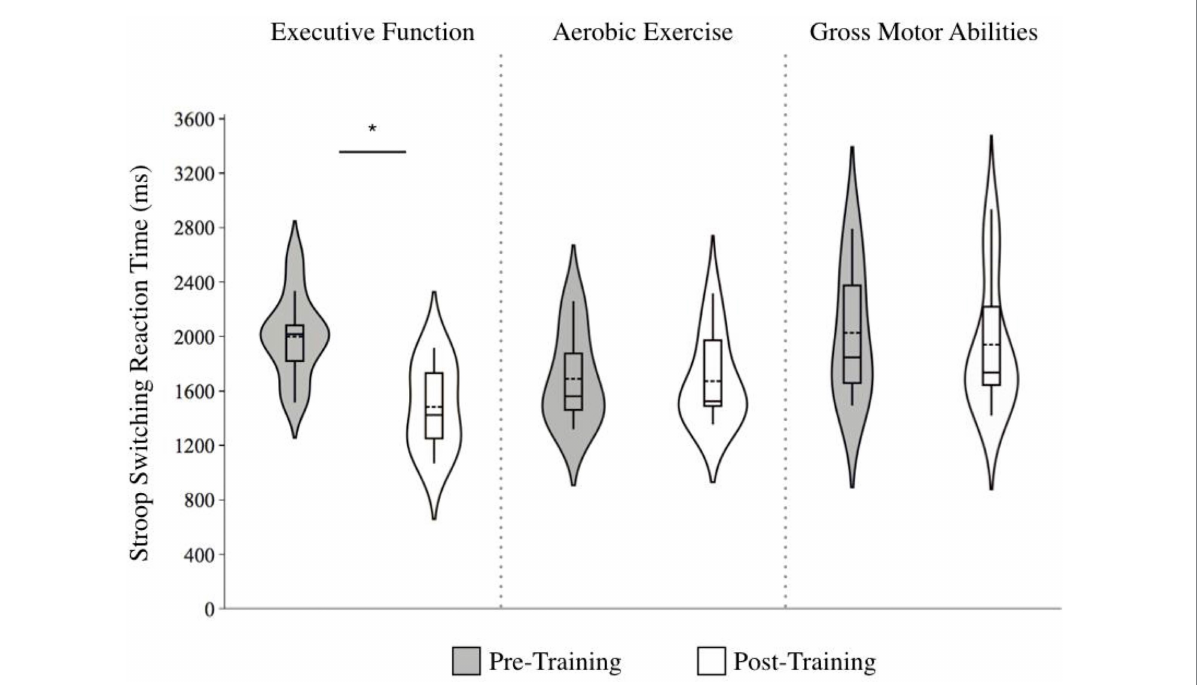
FIGURE 5 Violin plot of Stroop switching reaction times before and after training across training groups. Note: Lower scores indicate faster responses. The length of each curve represents the range of scores, the width represents the frequency of data points in each region, the solid line within each boxplot represents the median, and the dotted line represent the mean. There were significant improvements in reaction time for the executive function training group alone ( g = − 1.59 [large effect], ∆ = −